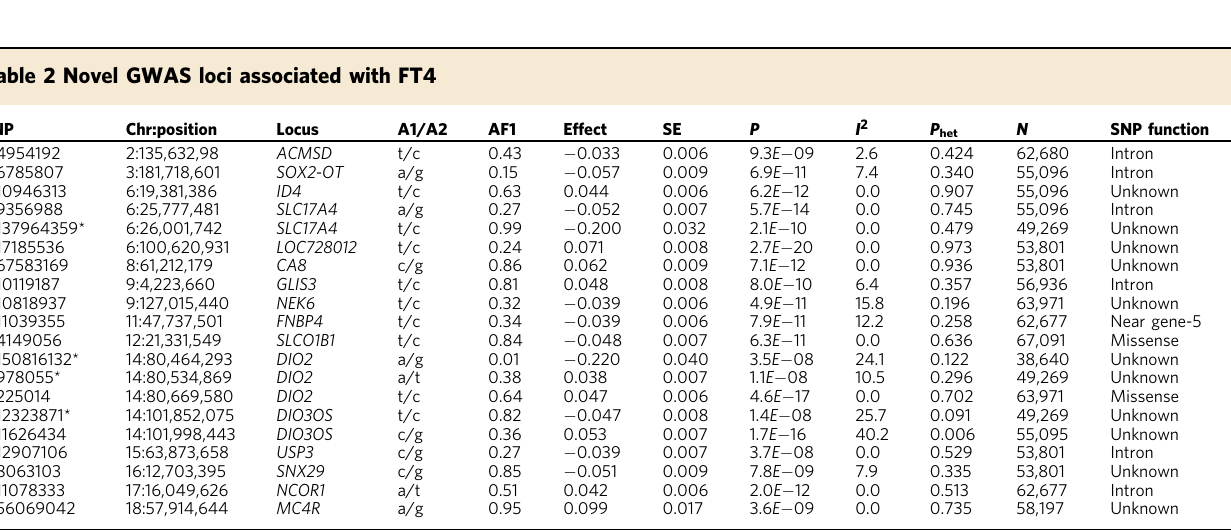
The table contains the list of the index SNPs and additional independent associations of replicated FT4 susceptibility loci. The values are provided for the combined discovery and replication sample, for additional independent hits (*) for the discovery stage only A1 effect allele, AF1 allele frequency of A1, SE standard error of the effect, P association p -value, I ² percentage of total variation across studies that is due to heterogeneity, N sample